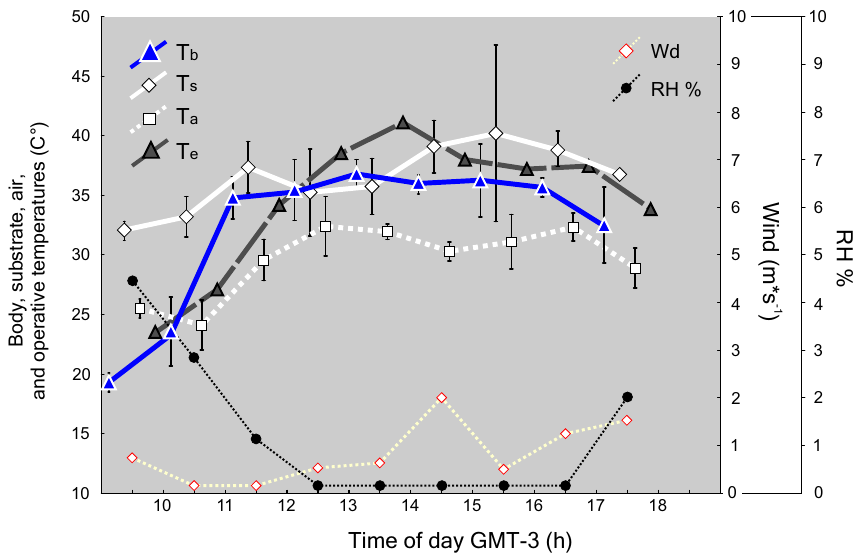
Figure 1. Variation during activity of mean body temperature (°C; T b , blue triangles with white foreground), microenvironmental temperatures: substrate (C°, T s , white diamond) and air (°C; T a , white squares) and operative temperatures (°C; T e grey triangles with black foreground) along the day (hour) of Liolaemus montanezi. Polygons connect the mean ± s.e.m. Wind velocity is indicated in the Y-right axis (m*s −1 , white diamond with red foreground—whitish dashed line polygon) and percentages of relative humidity are indicated in the doble Y-right axis (RH %, black circle—black dashed line